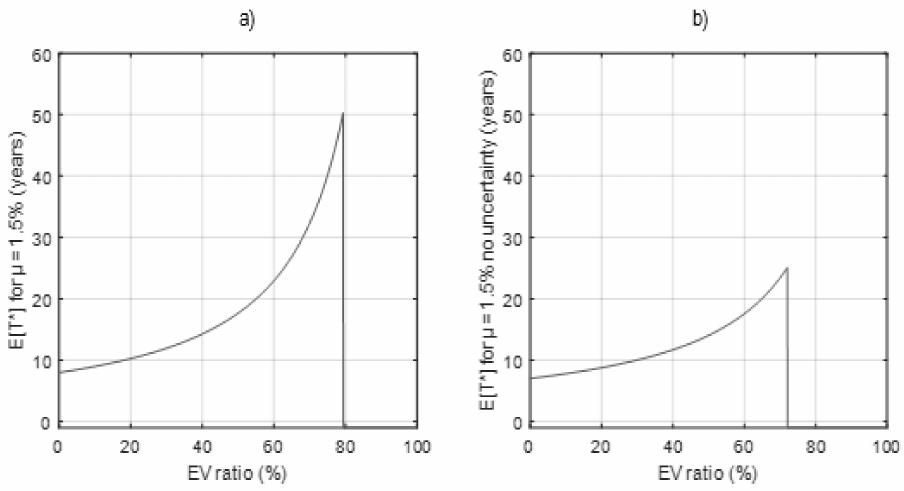
Figure 13. E [T*] for µ = 1.5% as a function of EV integration ratio (( a ) with uncertainty and ( b ) without uncertainty).